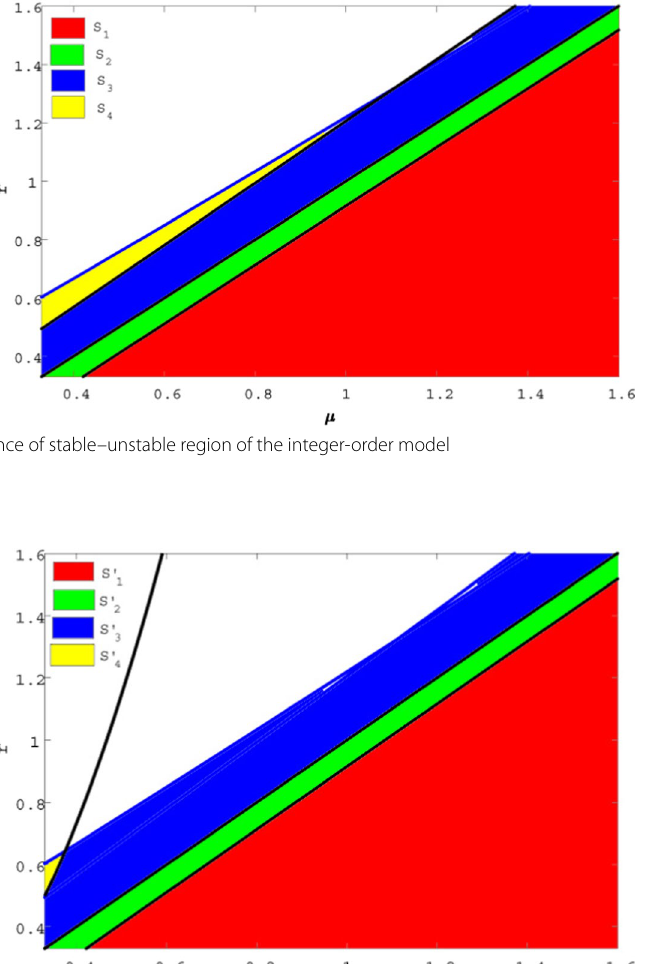
unstable region for E 2 of system (3) for µ < r in theorem 8.4.Taking the value of α = 0.95 for the fractional-order system(4) exhibits the stable and unstable region in ′ } satisfies theorem 9.1 ( vi ) the = { (µ , r ) : r < µ − A Fig. 13, where ( v ) the region S 1 g ′ < r < µ } satisfies theorem 9.2(a,b) ( vii ) the region = { (µ , r ) : µ − A region S 2 g 1 + gk ) } satisfies theorem 9.3 ( i ) , ( ii ) ( viii ) the region S ′ S ′ 3 = { (µ , r ) : µ < r < µ + A β( kA + d < r < µ + { (µ , r ) : µ + A β( 1 + gk ) kA + d =